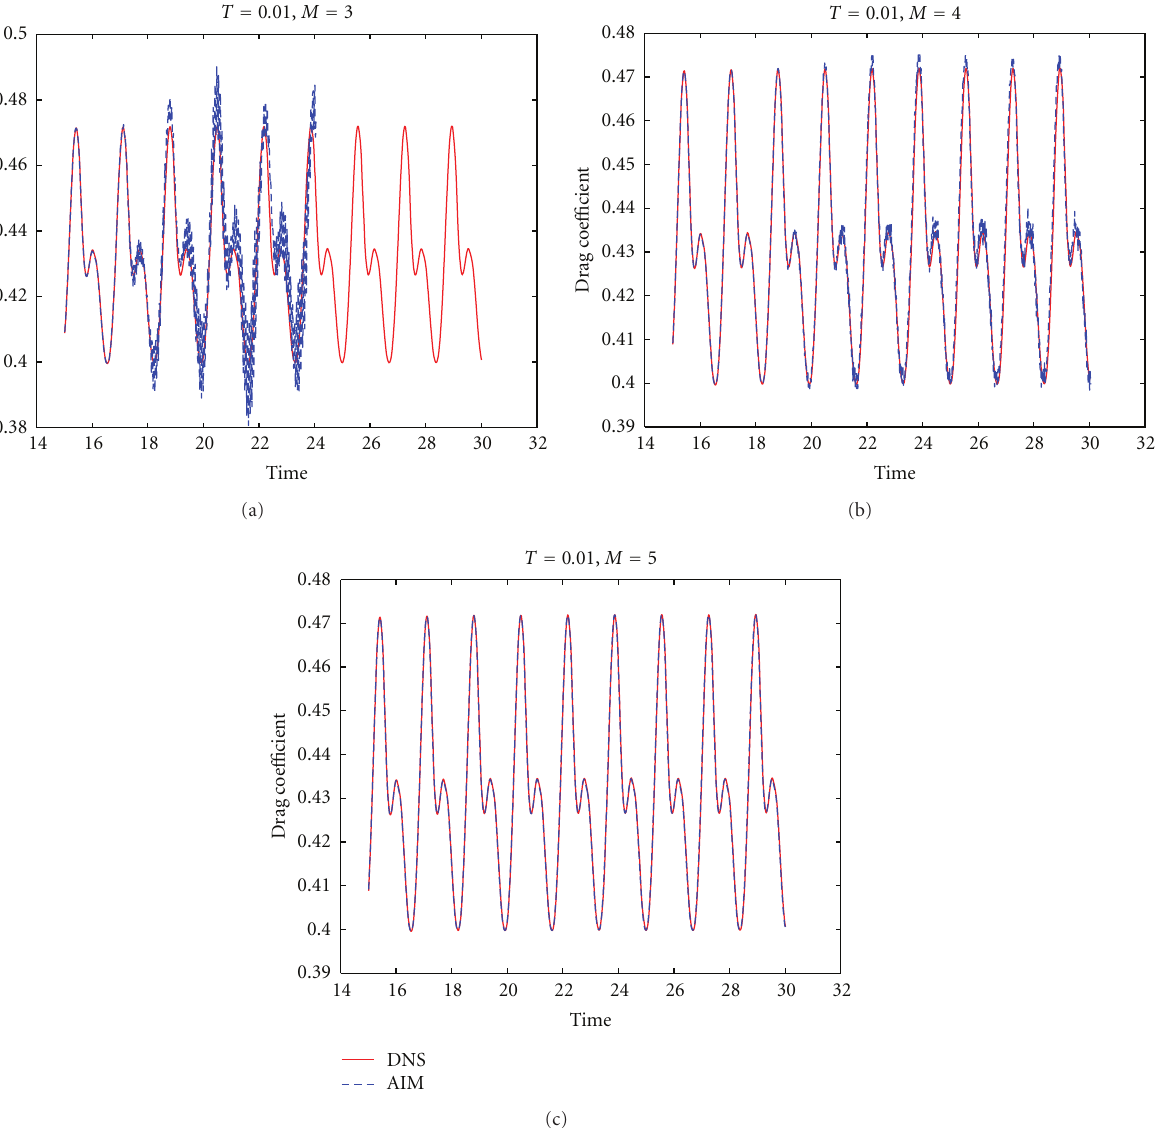
Figure 10: Periodic case: Re = 800. Computed drag coe ffi cient for T = 0 . 01 with various number of M . From top to bottom: M = 3,4, and